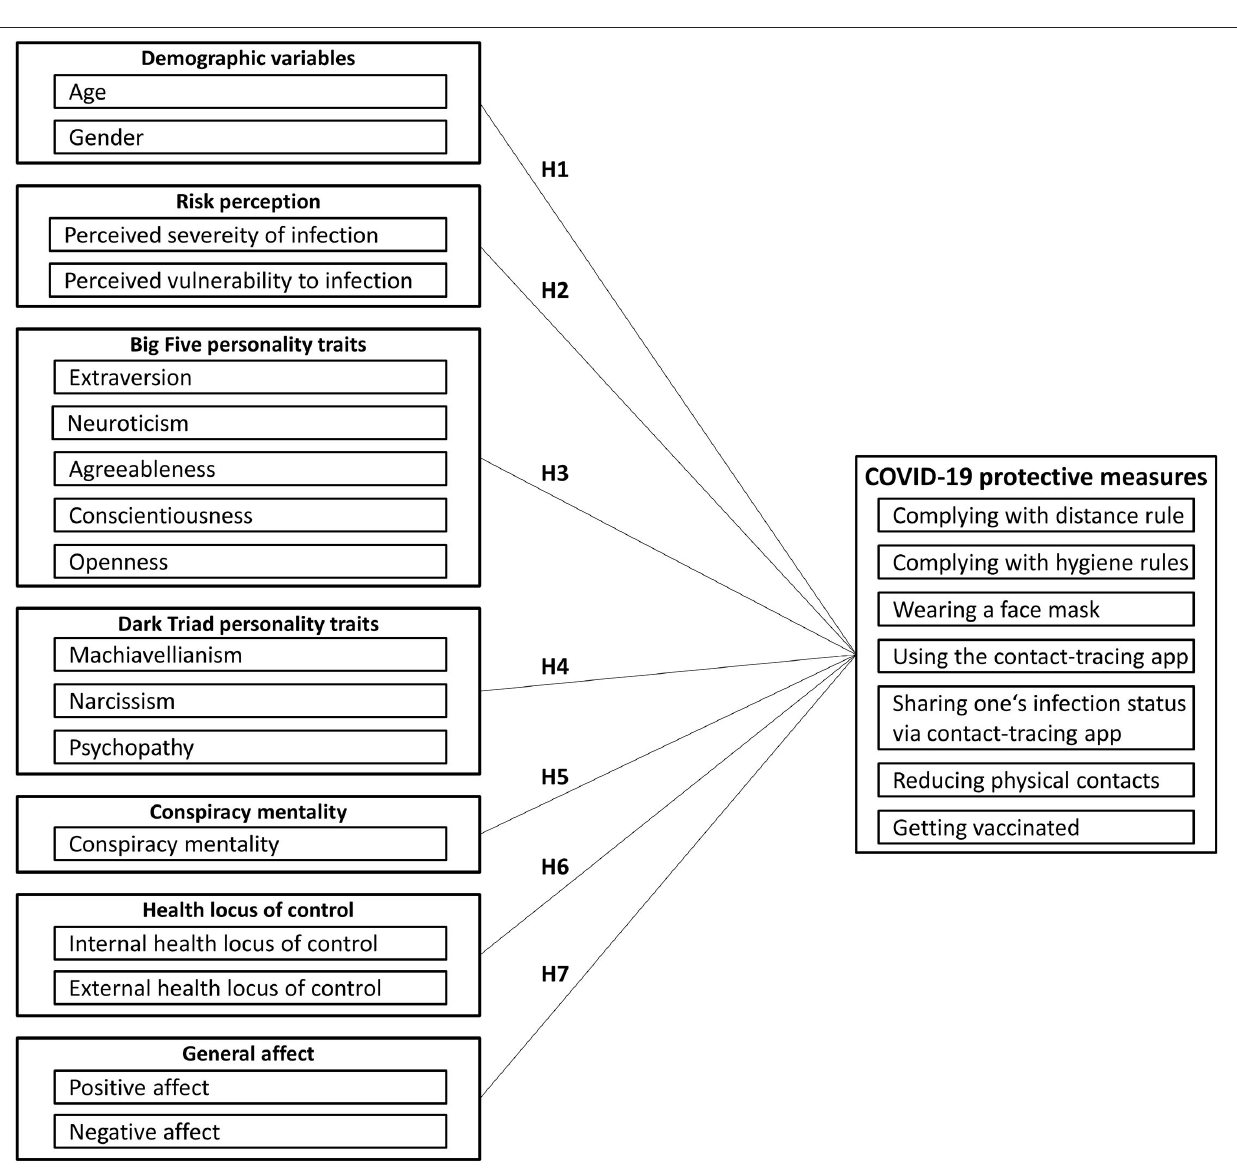
FIGURE 1 | Research model of the present